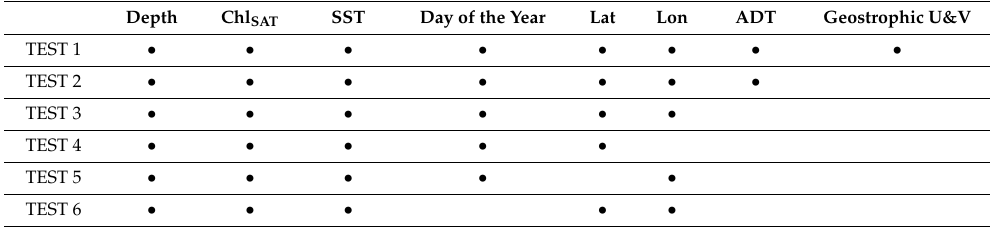
Table 2. Di ff erent combination of co-predictors used in the sensitivity analysis of inputs in the MLP